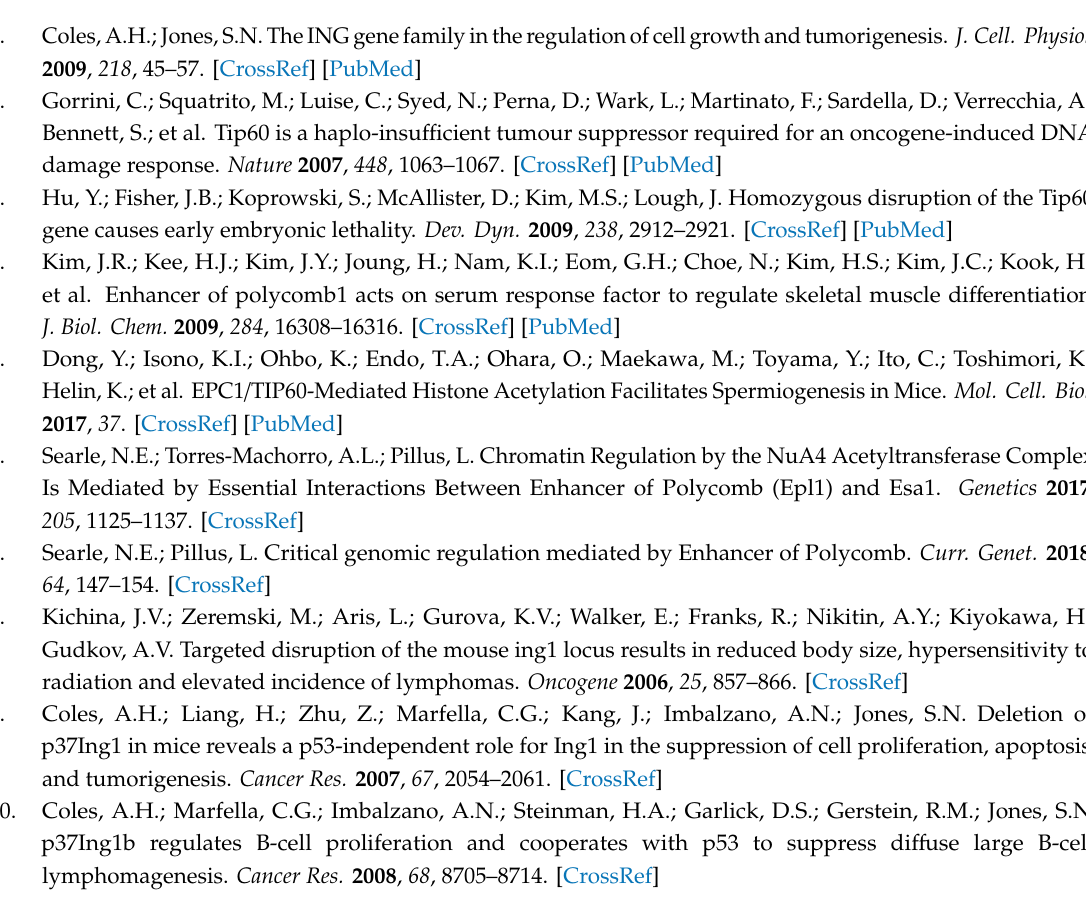
Figure S1: Western blot raw data, Video S1: µ CT video of rotating wild type embryo, Video S2: µ CT video of rotating heterozygous embryo, Video S3: µ CT video of rotating homozygous